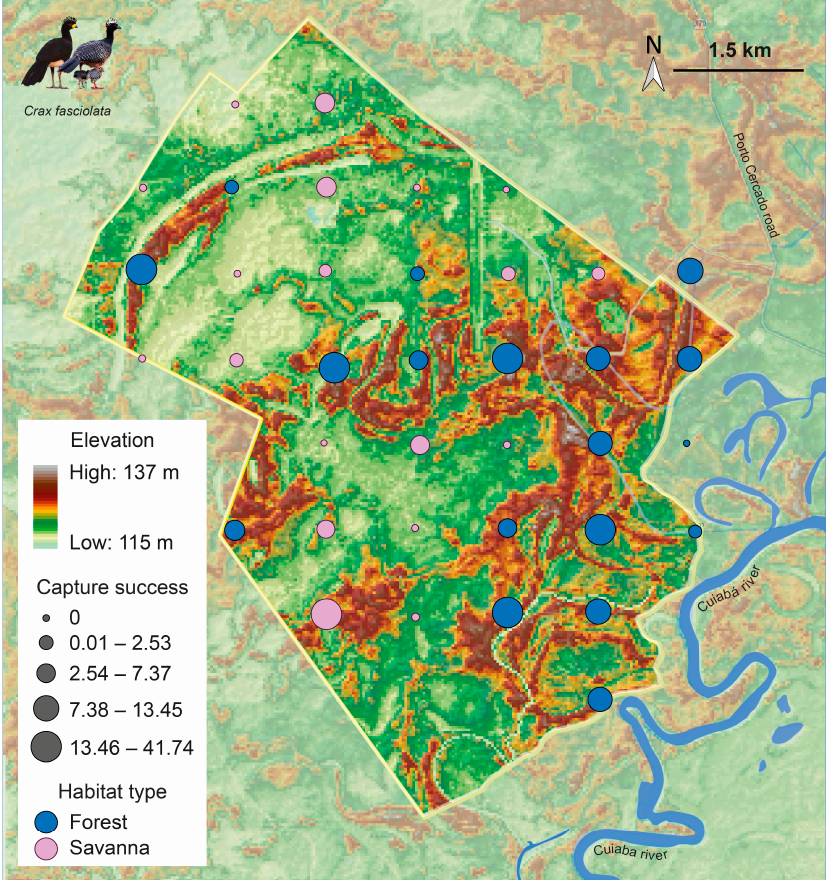
Figure 1. Topography of SESC Baía das Pedras Park (Northern Pantanal, Mato Grosso State, Brazil) at 30 m resolution (Copernicus WorldDEM-30 [50]) and associated sampling locations in a 1 km square grid (circles). Elevations in the area range from 115 m to 137 m, with an average of 122 m [49], and are shown with background colors depending on elevation. The smallest circles represent sampling locations where Bare-faced Curassow ( Crax fasciolata ) was not captured, and the remaining circle sizes represent values for capture success (number of independent captures per 100 sampling days) divided into equal quantiles, from lowest to highest. The pink circles represent sampling locations dominated by savanna, and the blue circles represent sampling locations dominated by forest.